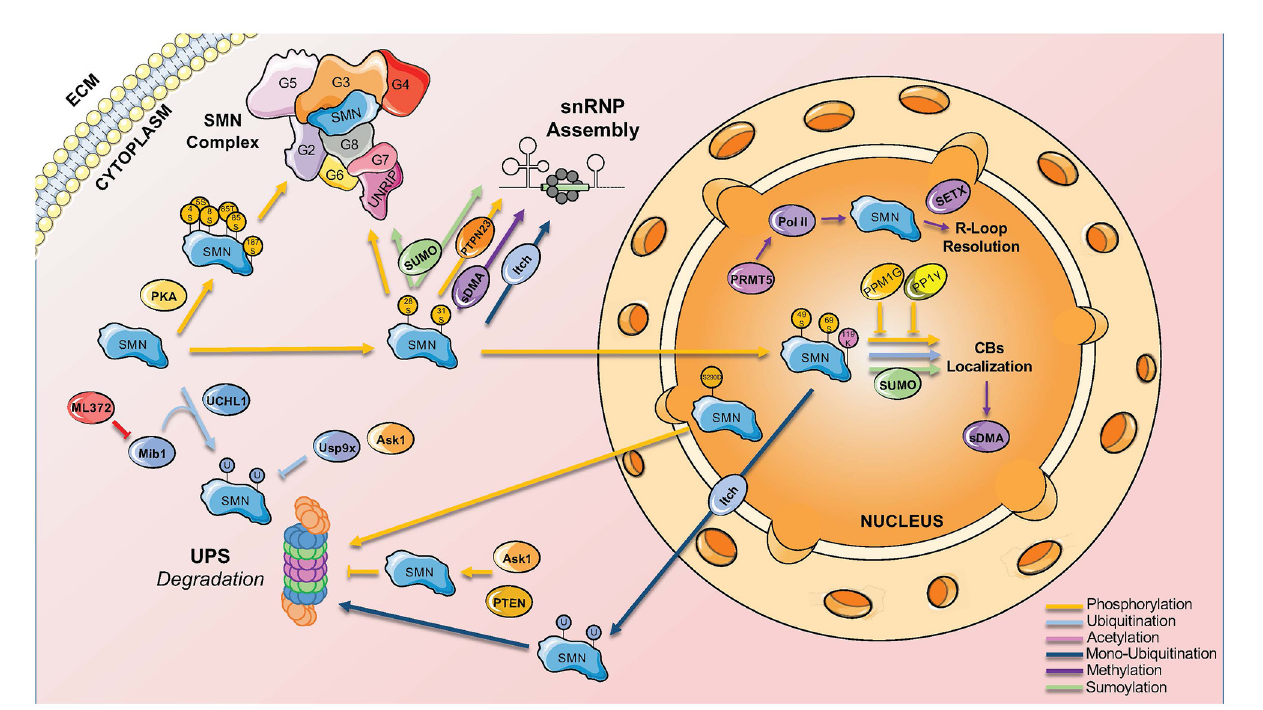
FIGURE2 Main PTMs involved in SMN complex functions and localization. SMN complex functions and nucleocytoplasmic location are finely regulated by different PTMs that bind to specific sites on the complex.